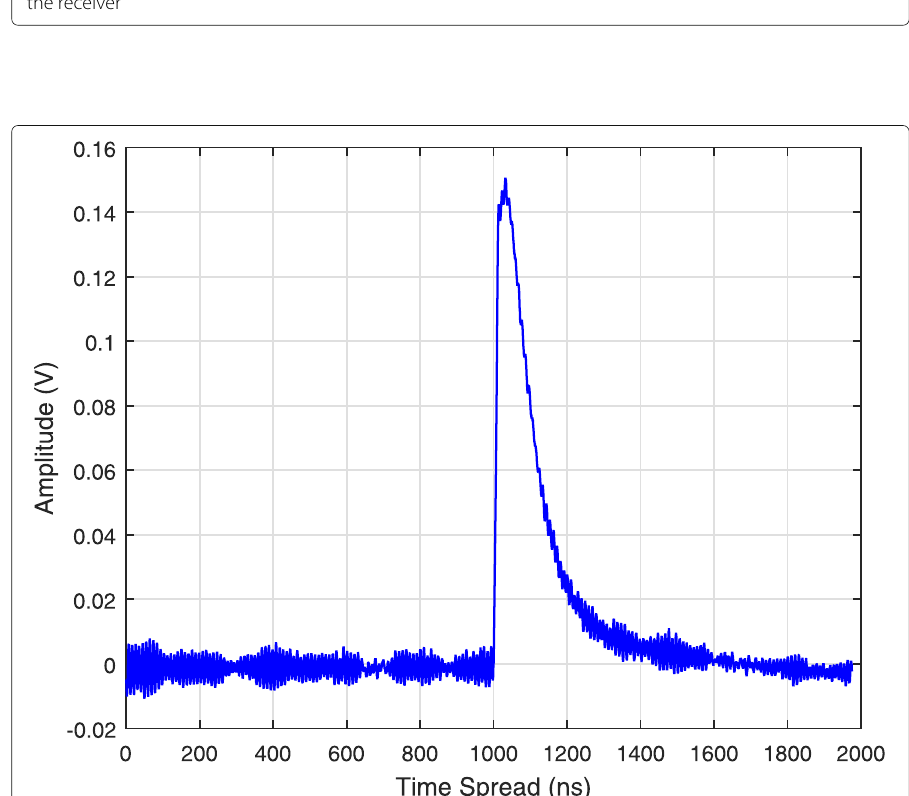
Fig. 7 Time response of LED. The signal captured by the oscilloscope for a pulse of 10 ns generated by AWG and sent via the